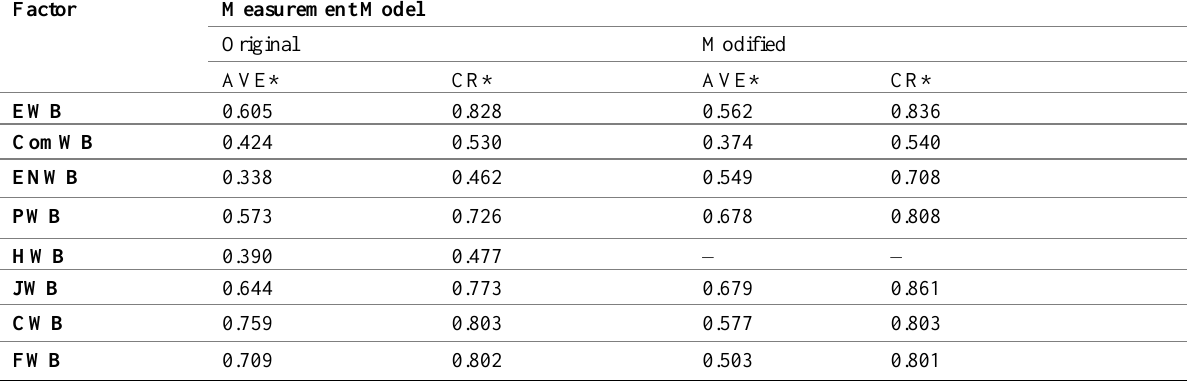
Table 3: AVE and CR values for each factor in the original and modified measurement models.